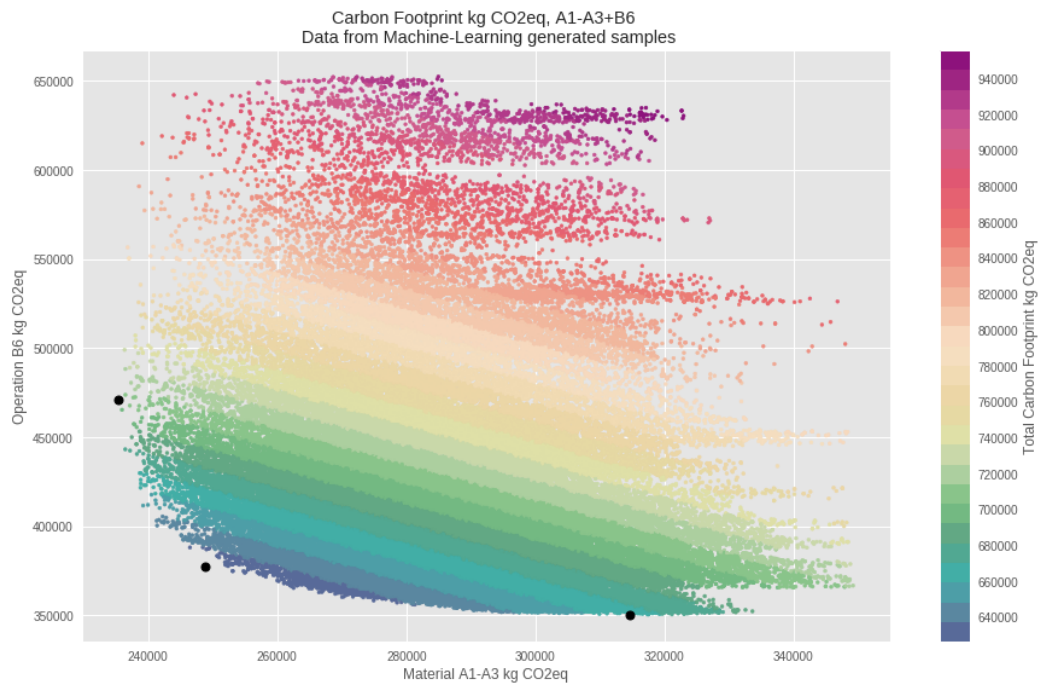
Figure 4. Scatterplot of Carbon Footprint of 100,000 predicted building shapes. Black dots mark the cases with the lowest Embodied Carbon ( left ), lowest Operational Carbon ( right ), and lowest Total Carbon ( middle ).